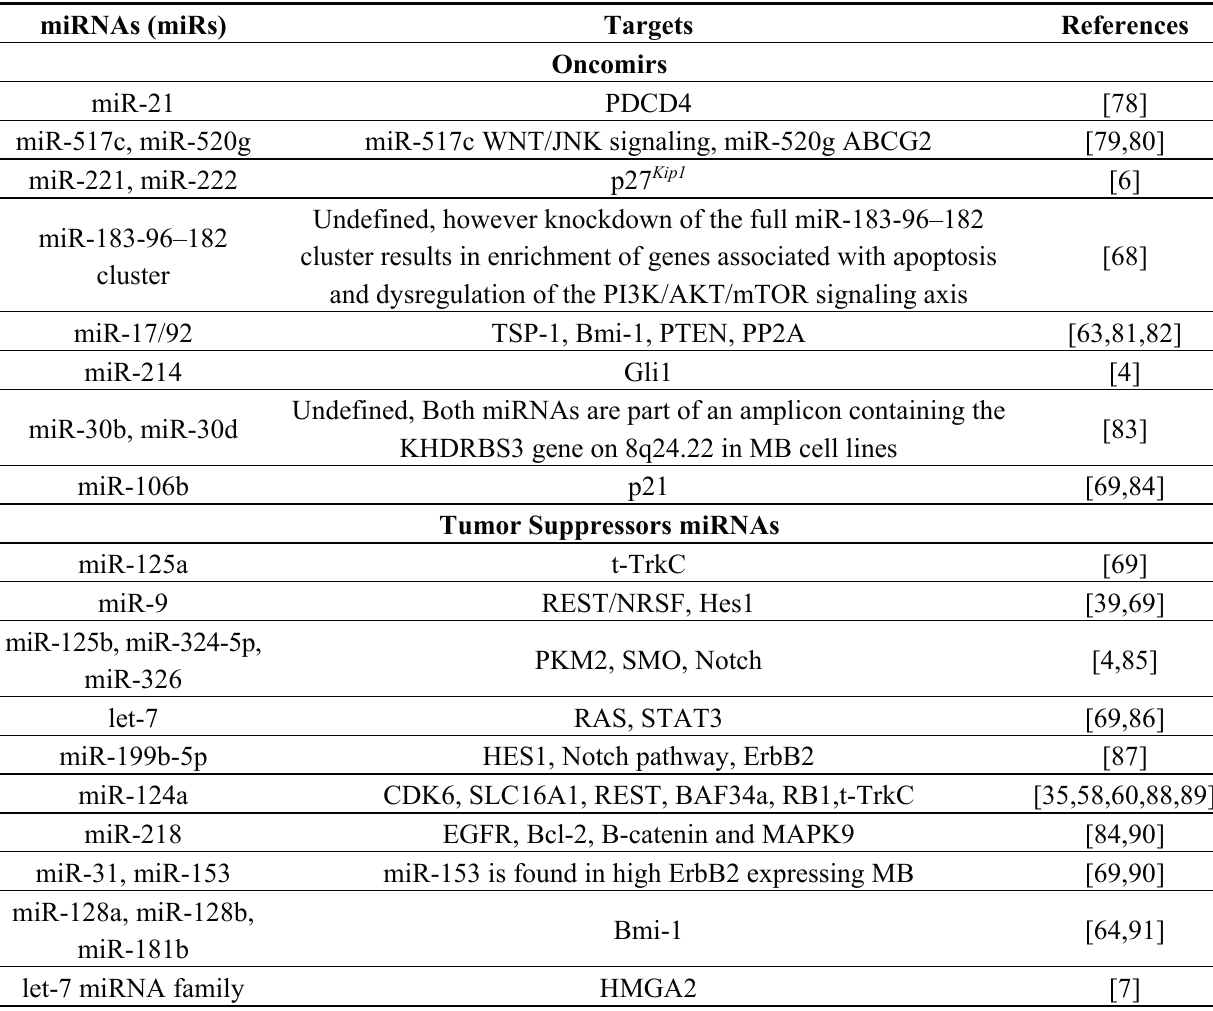
Table 1. MicroRNAs (miRNAs) involved in medulloblastoma (MB) biology as oncogenes or tumor